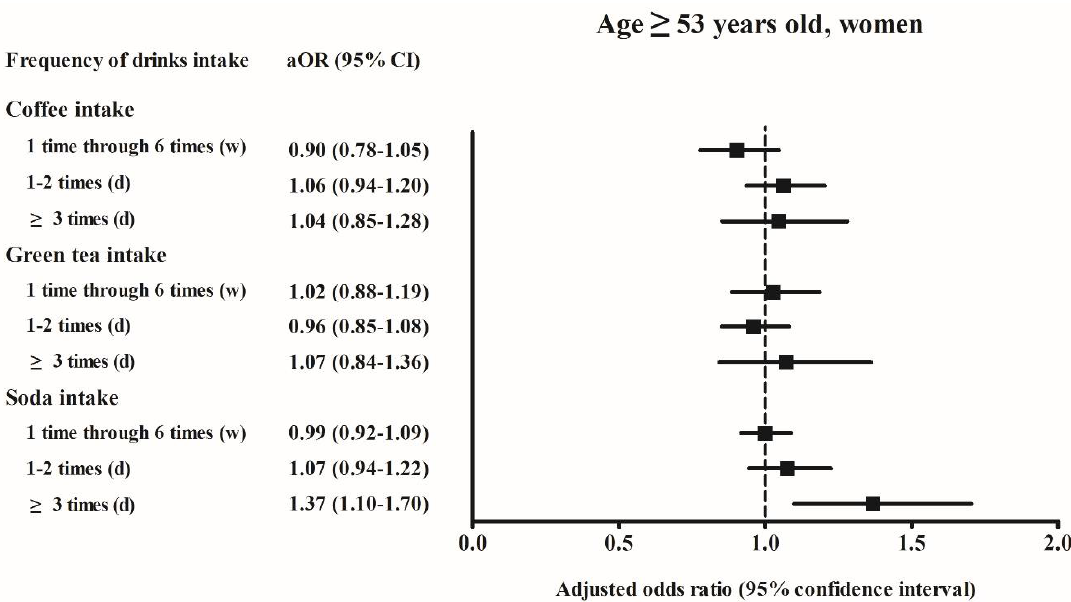
Figure 4. The adjusted odds ratio of the hyperuricemia according to the frequency of coffee/green tea/soda (soft drink) intake in the age < 53 years-old men. Fully-adjusted model (age, BMI, income, past medical histories, smoking, alcohol consumption, nutritional intake, frequency of coffee, green tea, and soft drink intake) was used.